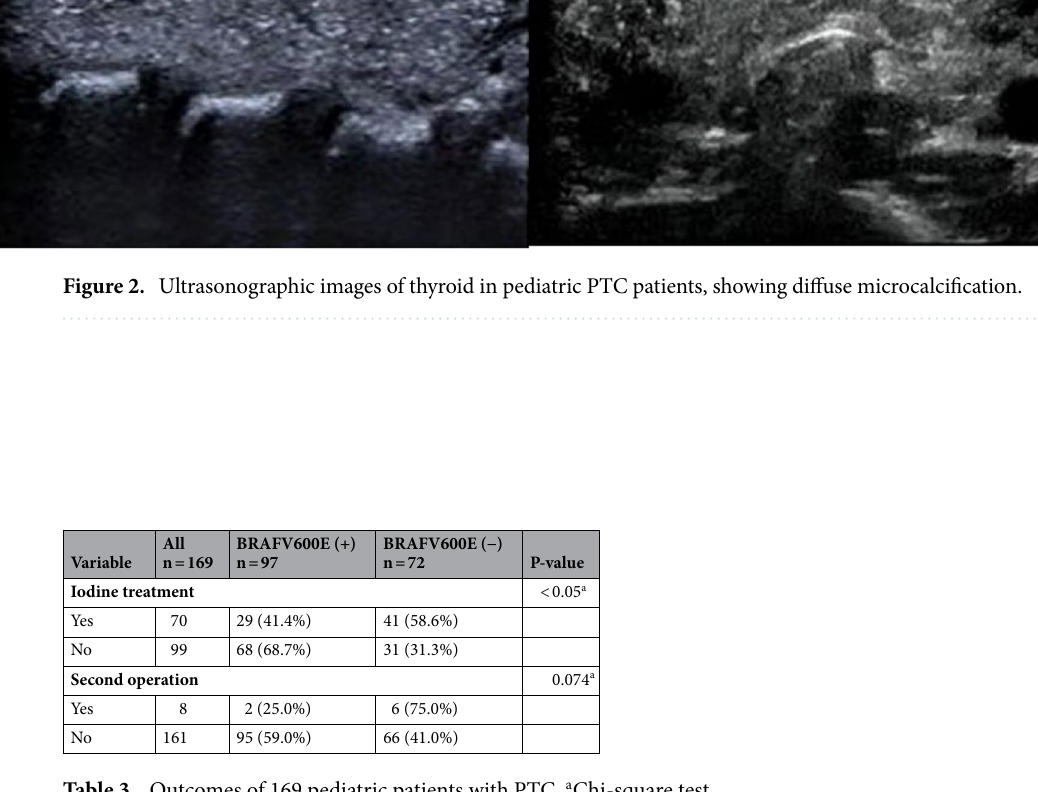
Table 3. Outcomes of 169 pediatric patients with PTC. a Chi-square